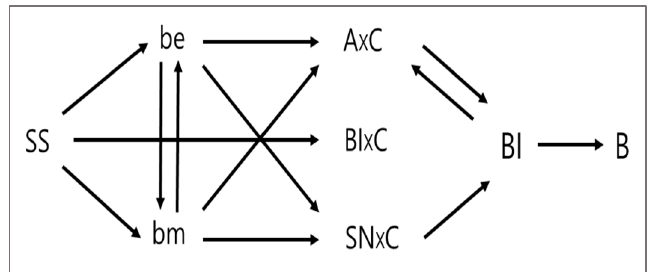
Figure 2. Accumulative revision of the Fishbein/Ajzen model. Source: Recited from Liska [90]. B = behavior ; A= attitude ; C = contingency variables ; BI = behavioral intention ; SN = subjective norms ; be = beliefs about the specific consequences of behavior multiplied by the evaluation ; bm = beliefs about the social expectations of specific others multiplied by the motivation to conform to them ; SS = social structure .